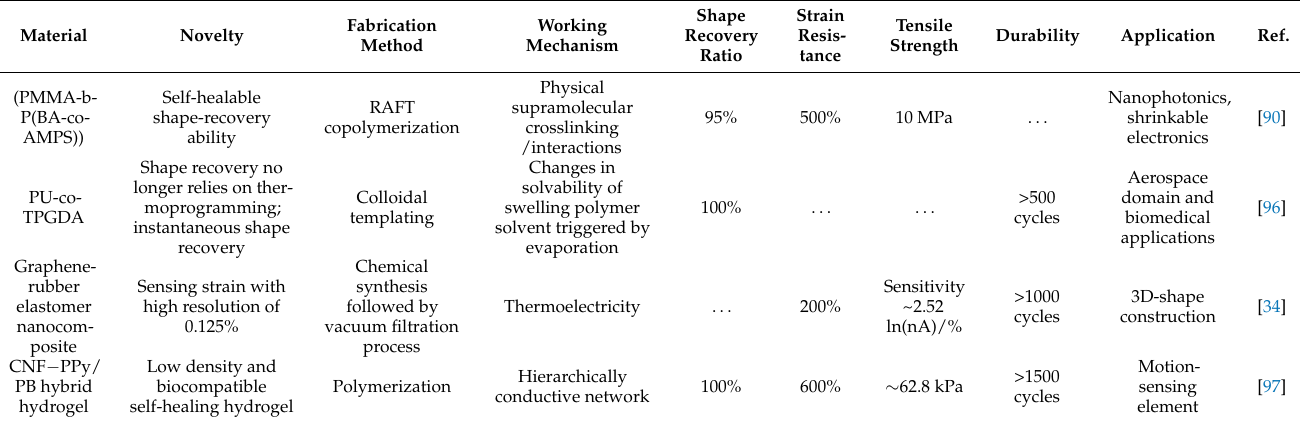
Figure 4. An overview on self-healing intelligent polymers: ( a ) self-healing mechanism of a metal conductor by liquid metal outflow from a polymer capsule [91]; ( b ) self-healing and stretching behavior of an HTS-PDMS gel under ambient conditions [95]; ( c ) self-healable thermoplastic material. The healing property relies on chain mobility and the rebonding of the molecular interactions (Reprinted from (Polymer, Volume 134, Zhang, J., Huo, M., Li, M., Li, T., Li, N., Zhou, J., Jiang, J., 2018. Shape memory and self-healing materials from supramolecular block polymers. Pages 35–43, 2018 with permission from Elsevier) [90]. Table 2. Comparison of selected novel intelligent polymers’ responses to mechanical deformation stimulus and their